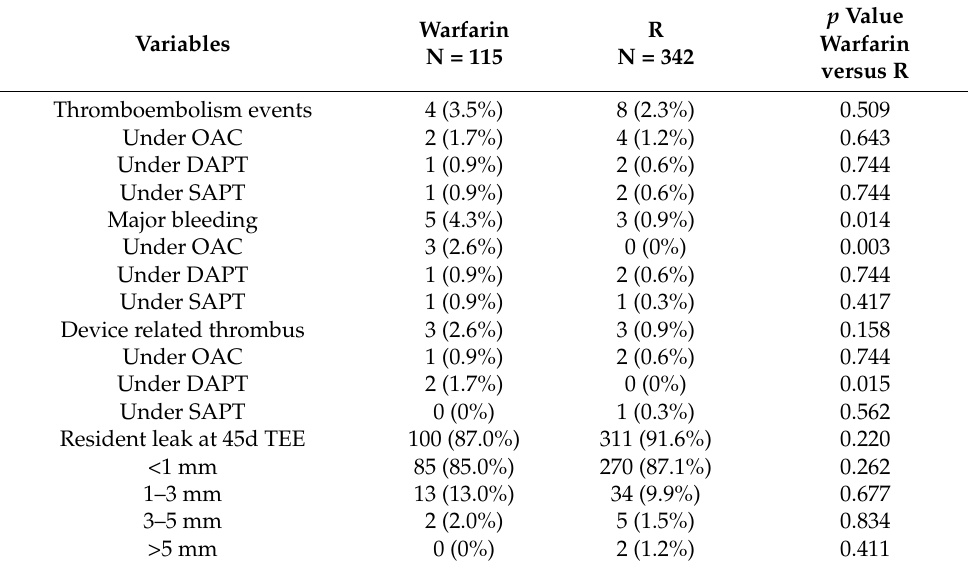
Table 3. Clinical outcomes stratified by warfarin and low-dose rivaroxaban.